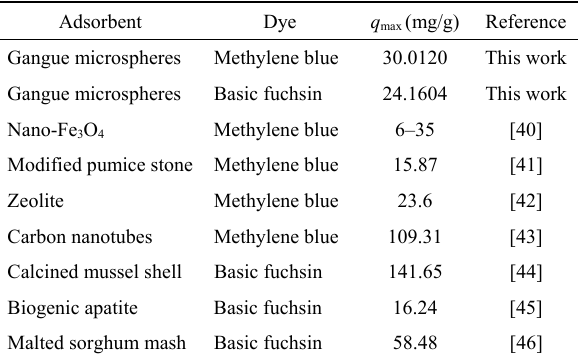
Table 4 Comparison of the adsorption capacities of some new adsorbents for removal